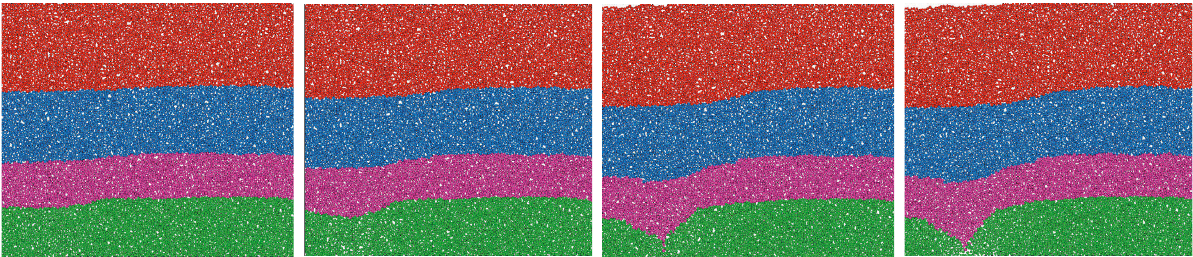
Figure 13: .Migration characteristics of top coal during the simulation of “two cuttings and one caving.”